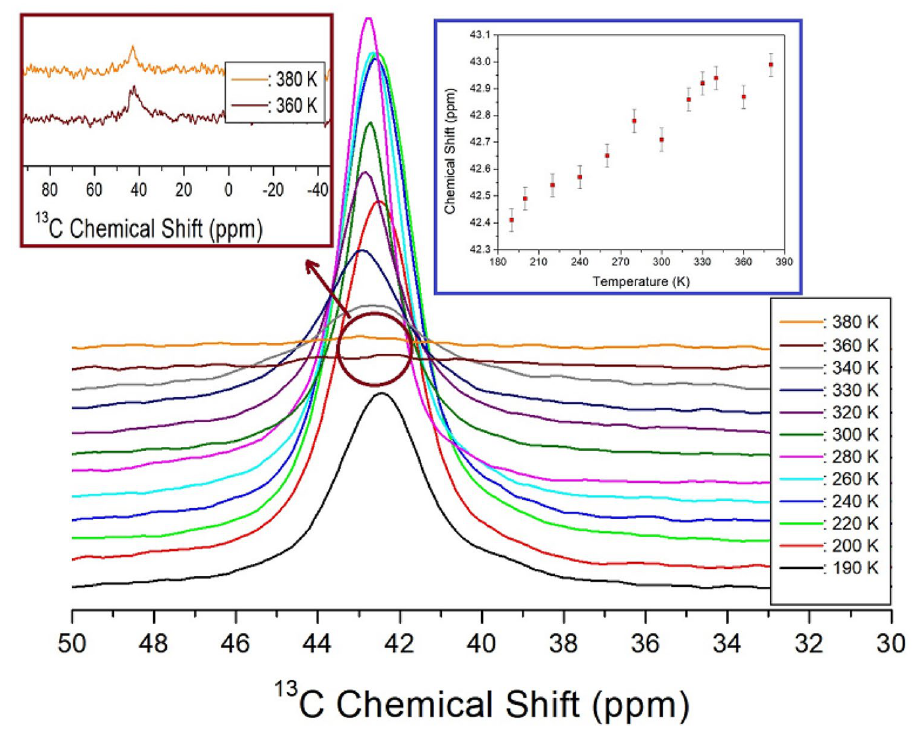
Figure 6. In-situ 13 C MAS NMR chemical shifts for [NH 3 (CH 2 ) 2 NH 3 ] 2 CdBr 4 ·2Br as a function of temperature (inset: 13 C MAS NMR chemical shifts for [NH 3 (CH 2 ) 2 NH 3 ] 2 CdBr 4 ·2Br as a function of temperature).